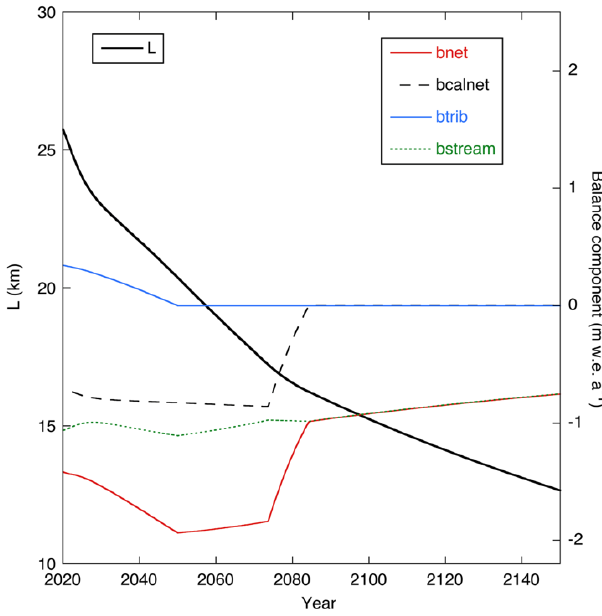
Figure 11. Glacier length (solid black line, scale at left) and mass balance components (scale at right) for the “Paris